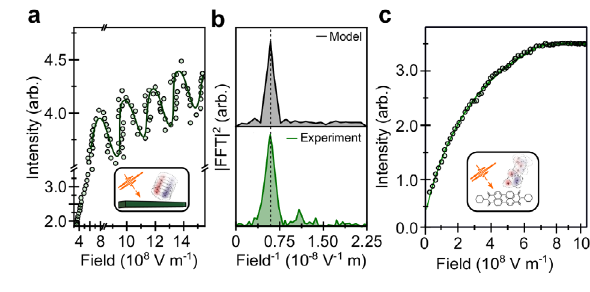
Fig. 2 Light-matter coupling in PDI nanobelts. a Emission intensity as a